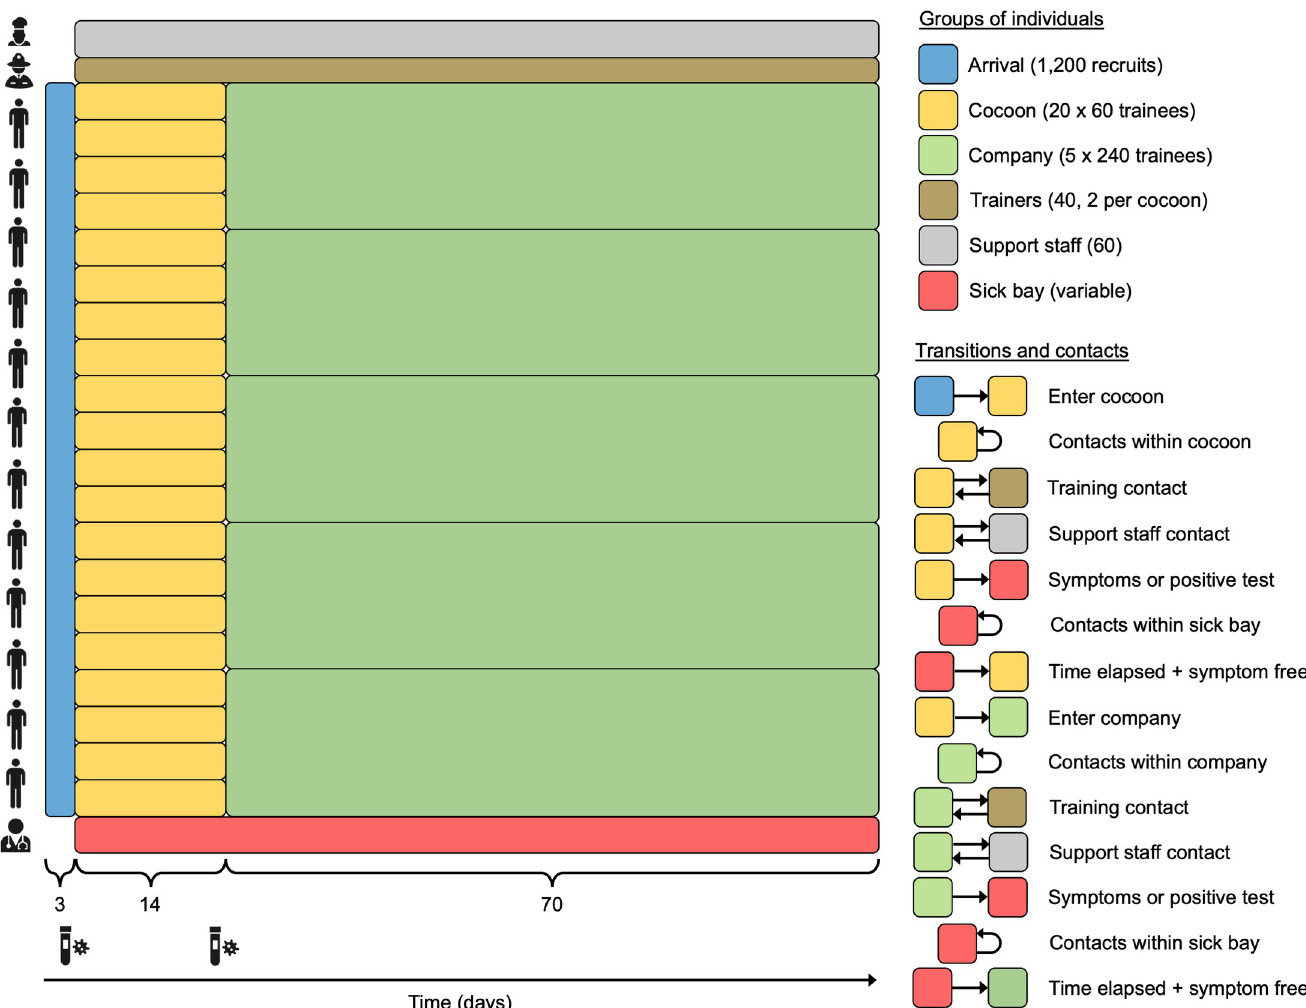
Fig 1. Model schematic. Trainees arrive in a three-day window (blue), progress to cocoons of 60 trainees each for 14 days (yellow), and then progress to companies of 240 trainees each for 56 days (green). Trainees have contact with other trainees in their cocoon or company, with trainers (brown) assigned to their unit (two per cocoon, eight per company), and with support staff (gray). Trainees who test positive following arrival testing or presentation with symptoms are placed in the sick bay (red) for ten days before returning to their unit. Trainers and support staff who test positive following presentation with symptoms isolate from home for ten days. New cohorts like the one depicted here enter training posts on a weekly basis, but we model only one given that cohorts do not interact with one another. All processes in the model are defined on a daily time